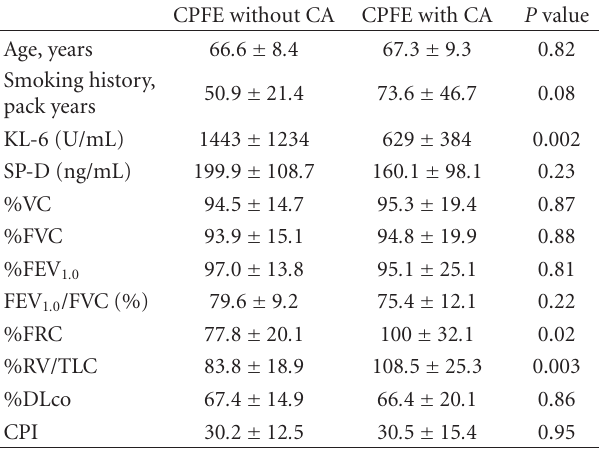
Table 2: Pulmonary function tests in CPFE patients. Table 3: Age and smoking history, KL-6, SP-D, pulmonary function tests, CPI in CPFE without lung cancer (CPFE without CA), and CPFE with lung cancer (CPFE with CA) at